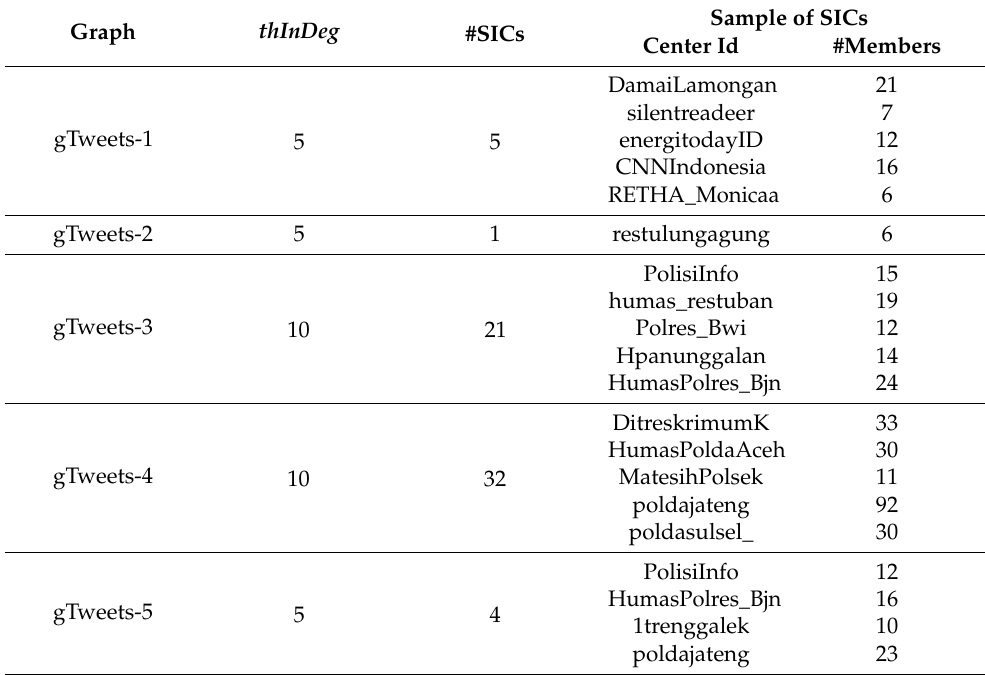
Table 4. Description of few